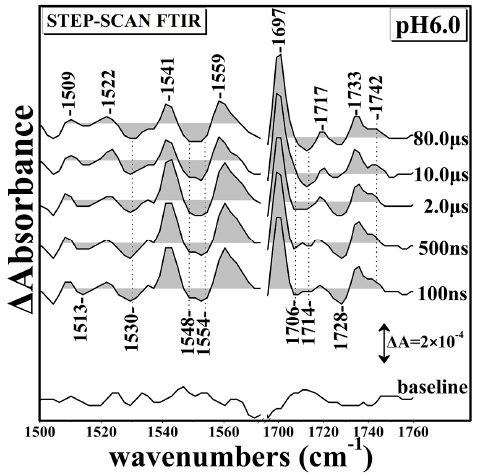
Figure 2. Time Resolved Step-Scan Fourier Transform Infrared (TRS 2 -FTIR) difference spectra of 1500–1760 cm − 1 region ( t d = 100–80,000 ns, 4 cm − 1 spectral resolution) of fully-reduced ba 3 -CO subsequent to CO photolysis by a 7 ns 532 nm laser pulse at pH 6.0.